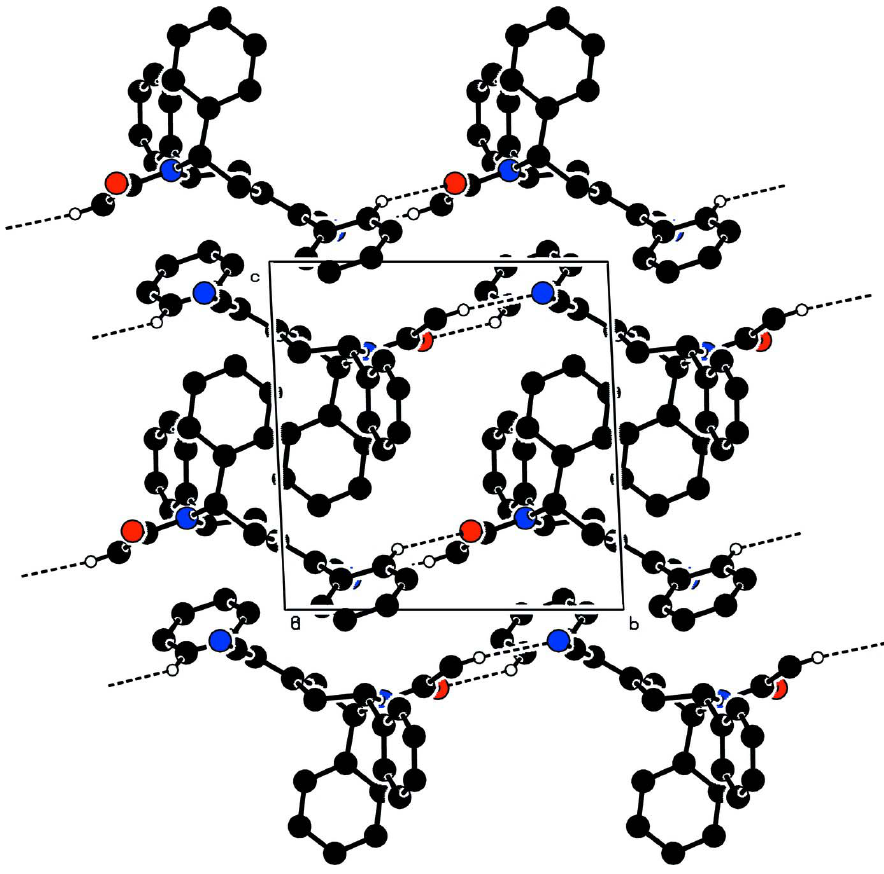
The molecular packing of the title compound, viewed down the a axis. Dashed lines indicate hydrogen bonds. H atoms not involved in hydrogen bonding have been